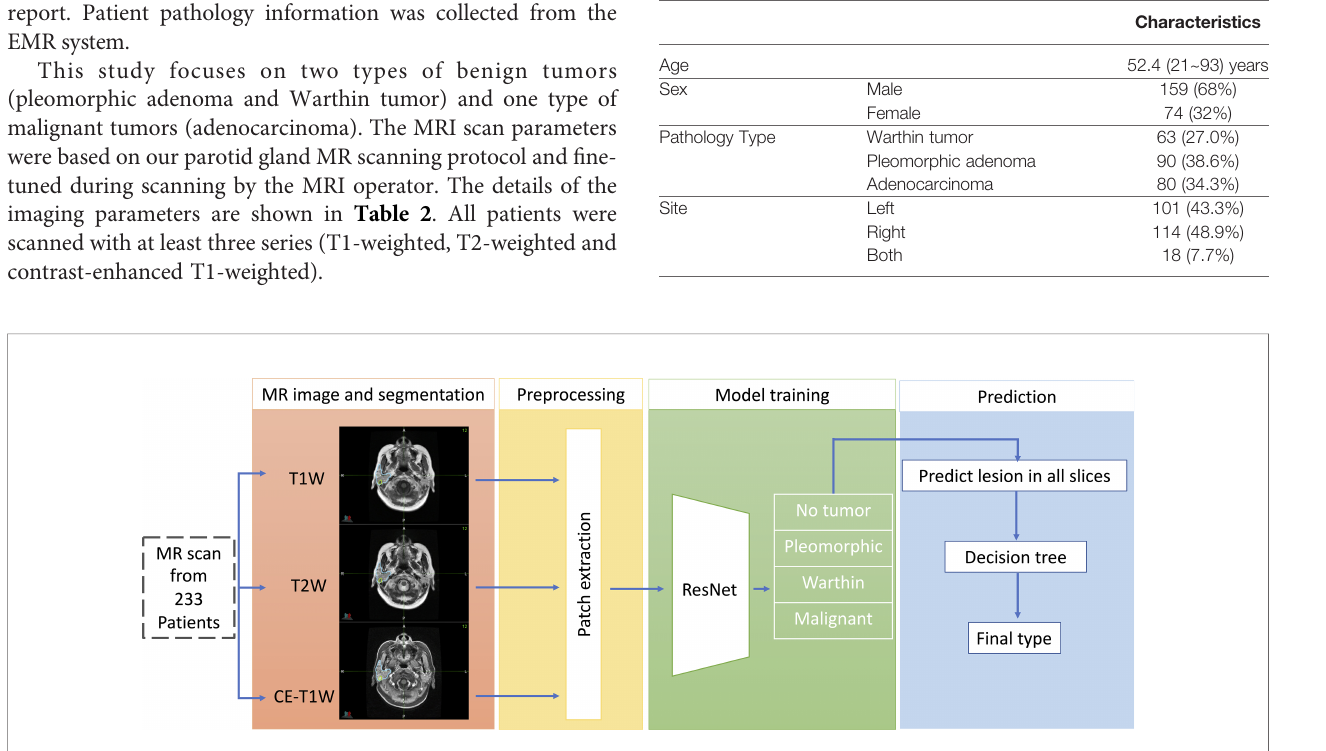
FIGURE 1 | The work fl ow of our proposed deep-learning framework for the differentiation of benign from malignant parotid lesions. The fi rst part shows multimodal MR images and tumor segmentation. The second part shows the preprocessing stage for the MR images. The third part shows the training network prediction model and tumor type classi fi cation. The fi nal part comprehensively shows that predictions are made for all slices to determine the tumor type.